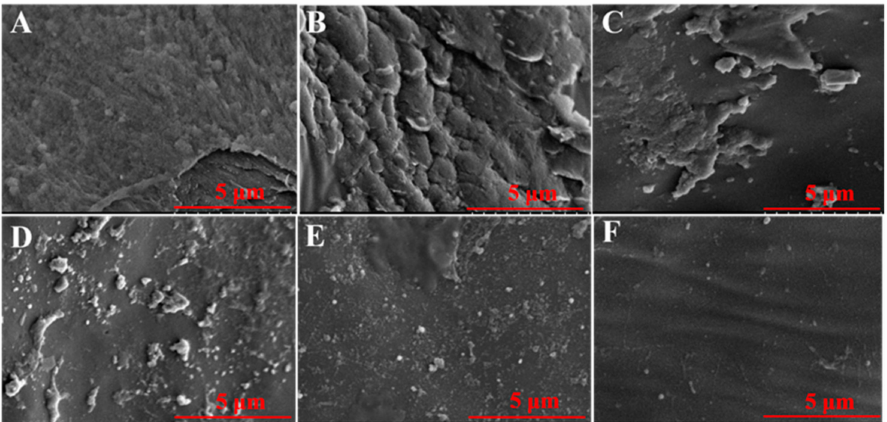
Figure 8. SEM images of peritoneal implants from mice treated with combinations of vancomycin and / or thymol. ( A ) PBS group, ( B ) thymol group (20 mg / kg), ( C ) vancomycin group (40 mg / kg), ( D ) low-dose combination treatment group (vancomycin hydrochloride 40 mg / kg + thymol 5 mg / kg). ( E ) middle-dose combination treatment group (vancomycin hydrochloride 40 mg / kg + thymol 10 mg / kg), and ( F ) high-dose combination treatment group (vancomycin hydrochloride 40 mg / kg + thymol 20 mg / kg). 2.7.3. Vancomycin in Combination with Thymol Relieved the Pathological Damage Caused by MRSA Infection